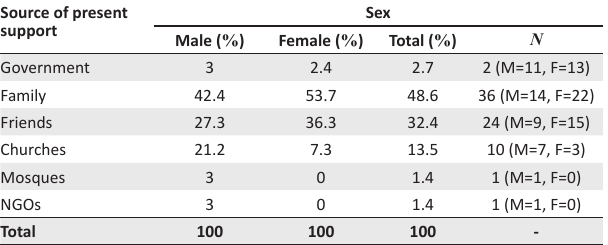
TABLE 10: Sources of present support by sex ( N = 73 Females 41 and Males 33). Source of present